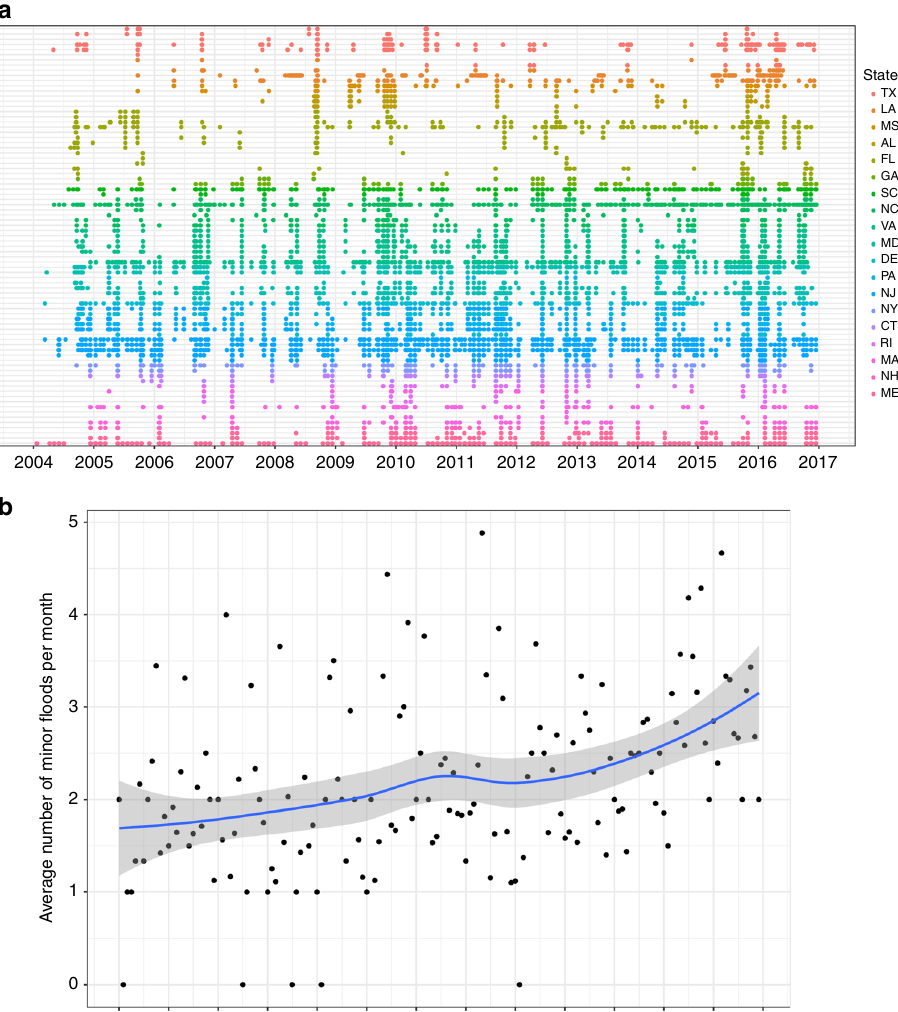
Fig. 1 Geographic and temporal patterns of tidal fl ooding in the Atlantic and Gulf Coasts of the United States. a Representation of fl ood frequency for 83 tidal gauge stations along the Atlantic and Gulf coasts of the United States. Each row is a different gauge and dots show days when maximum tide height exceeded minor fl ood stage for that gauge. Gauges are ordered geographically from north to south along the Atlantic coast, and then east to west along the Gulf coast. Colors show the state of each gauge. b Average number of days per month with maximum tide height exceding minor fl ooding threshold for the 83 gauges shown in a . The line shows a loess regression through the data with 95% con fi dence